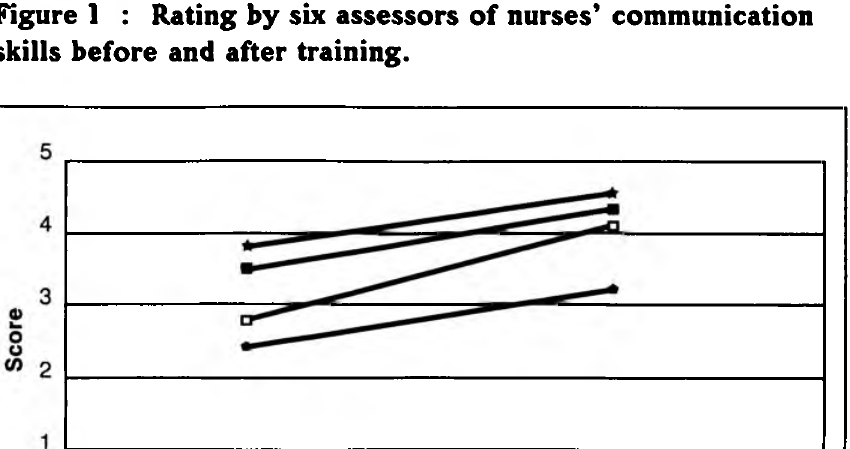
Figure 1 : Rating by six assessors of nurses’ communication skills before and after